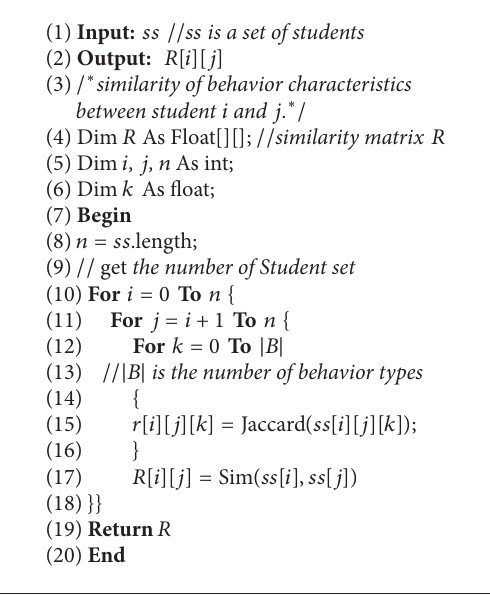
Algorithm 1: Jaccard coefficient algorithm.